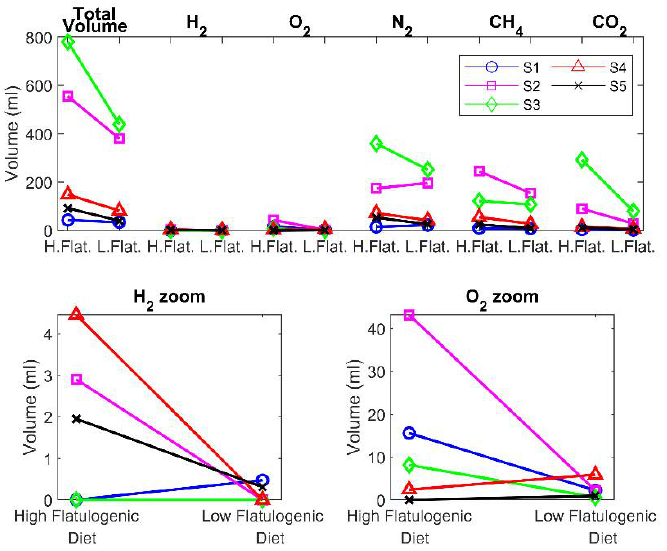
Figure 4. Univariate comparison of diets. Comparison of the total volume of all gases, volume of hydrogen, oxygen, nitrogen, methane, and carbon dioxide produced by subjects submitted to a high-flatulogenic diet and low-flatulogenic diet. S1 to S5 are the subjects.